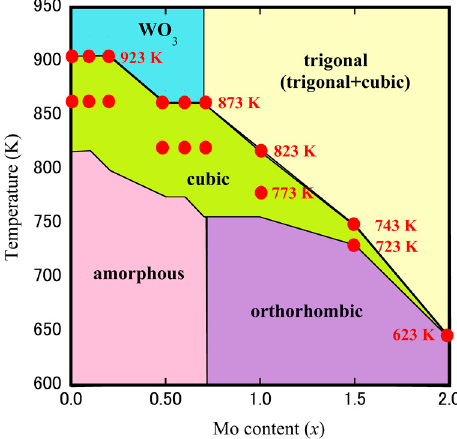
Figure 3. HT-XRD patterns of the ZrW 2 − x Mo x O 7 (OH) 2 ·2H 2 O ( a ) x = 0.0; ( b ) x = 1.0 precursors.